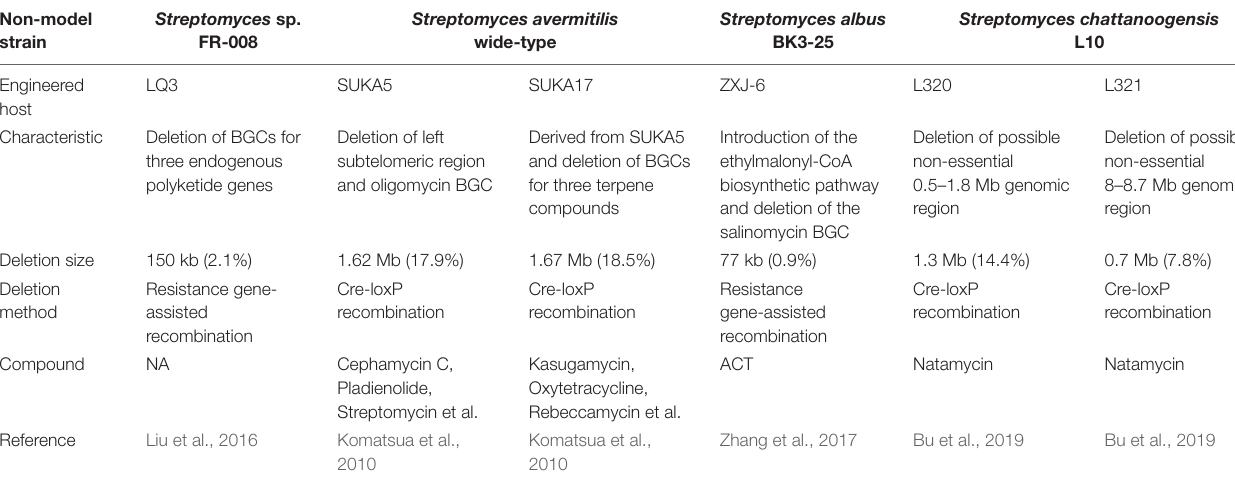
TABLE 2 | Characteristics of synthetic non-model Streptomyces chassis.